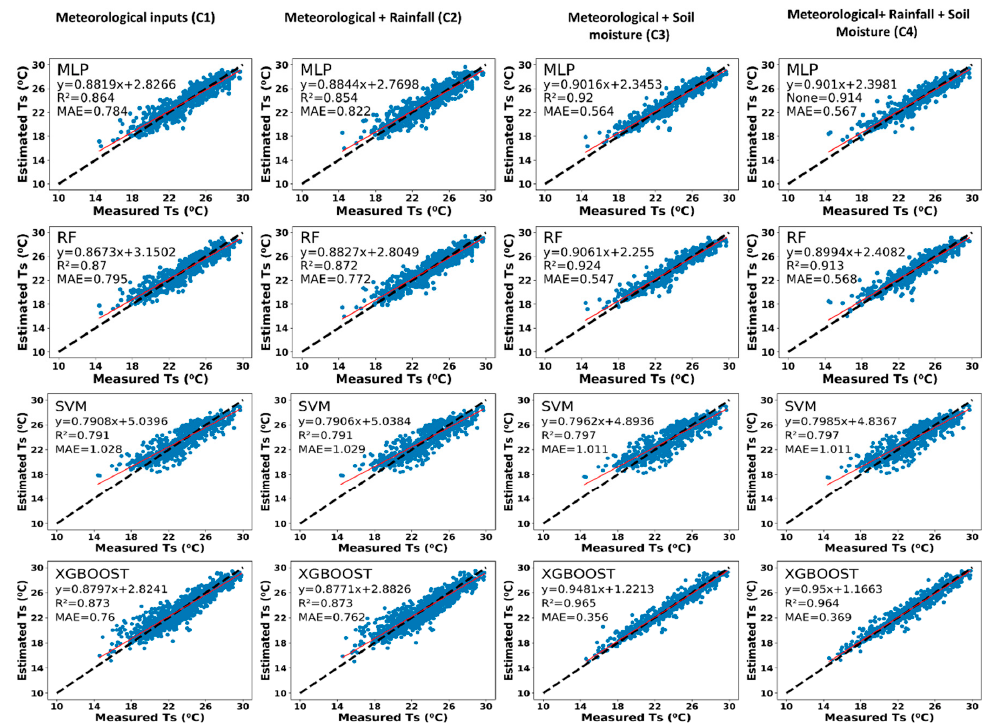
Figure 9. Scatter plots between estimated and measured hourly soil temperature (Ts) showing R 2 and MAE of 16 di ff erent model combinations for grassed hillslope (black dashed line represents 45 degree line and red solid line represents regression